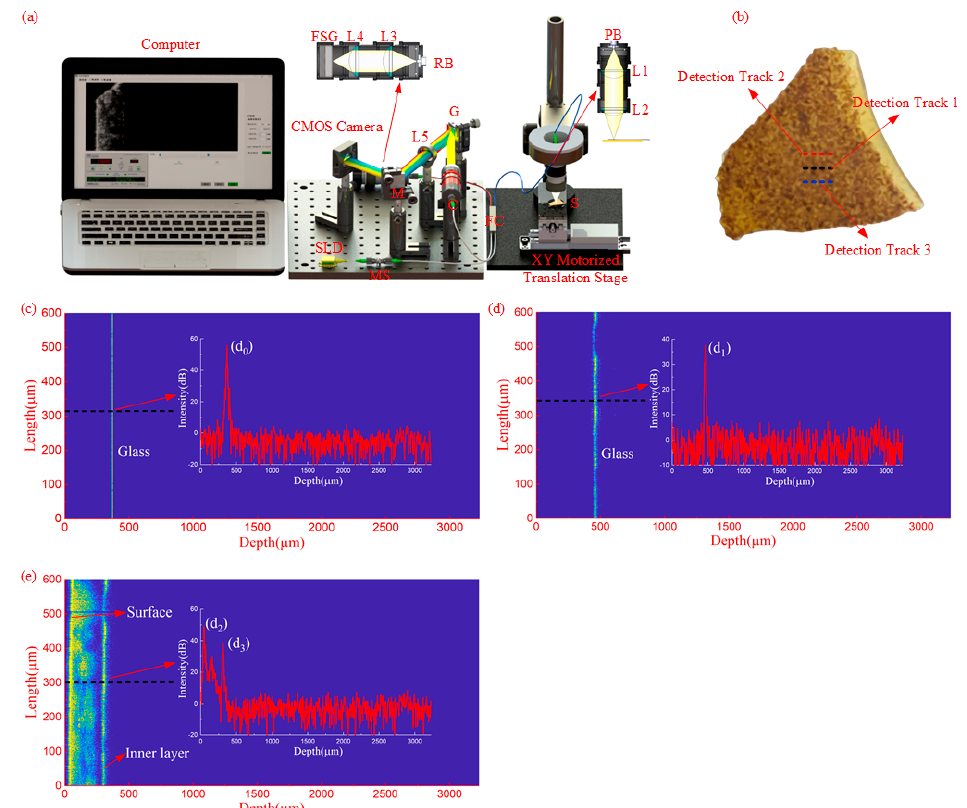
Figure 4. Geometric thickness and group refractivity measurement for the peeled-off self-lubricating fabric liner ( a ) the photo of experimental system; ( b ) the peeled-off self-lubricating fabric liner; ( c ) the tomography before inserting the liner into the probe beam; ( d ) the tomography after inserting the liner into the probe beam; ( e ) the tomography of the peeled-off self-lubricating fabric liner.